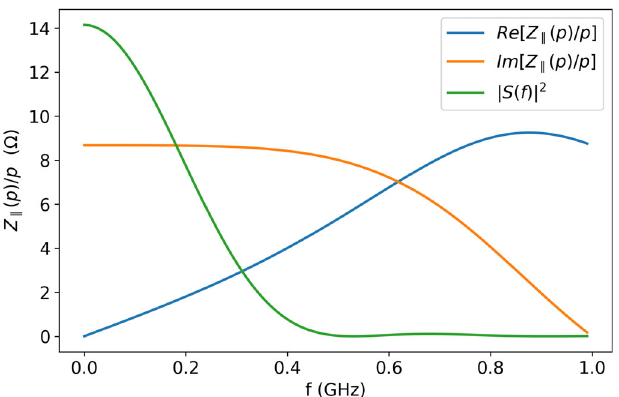
FIG. 1. Real and absolute imaginary part of Z BBR impedance as a function of frequency. In the same plot also the bunch spectrum of a parabolic line density distribution with total bunch length of 2.7 ns is represented in arbitrary